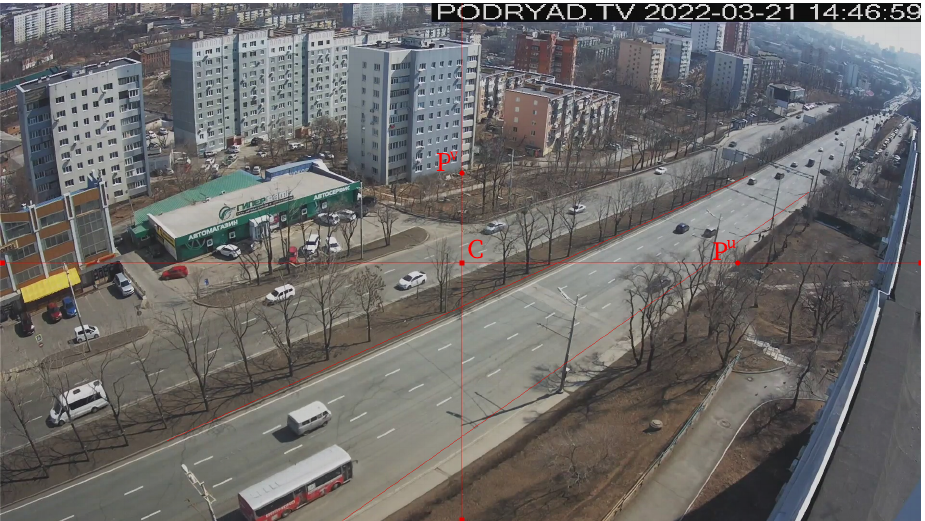
Figure 3. Field of view of the public street camera in Vladivostok. Example 1, image Φ .